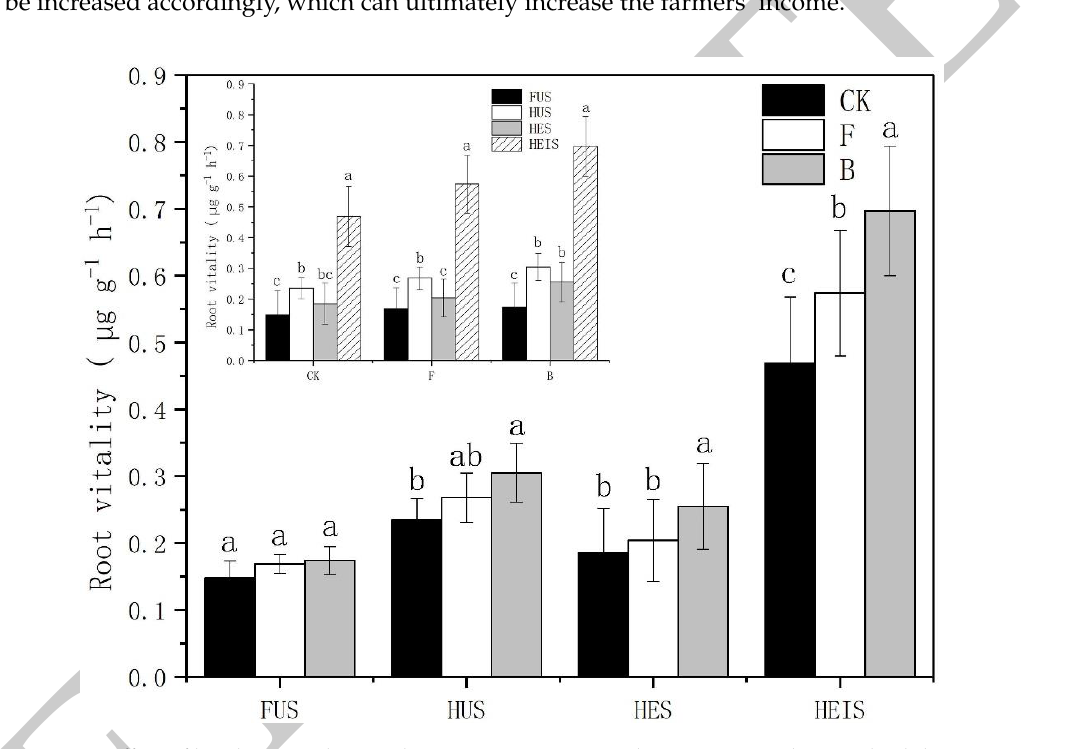
Figure 2. Effect of biochar on tobacco plant root activity. Error bars represent the standard deviation from the mean, p > 0.05. CK: control treatment, F: treatment with nitrogen fertilizer, B: treatment with